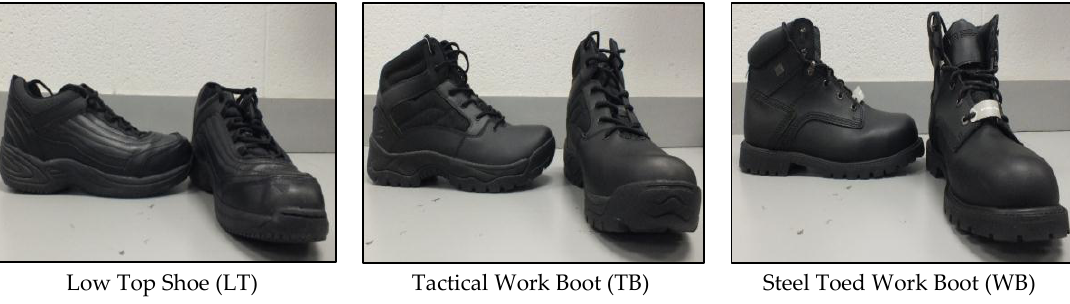
Figure 1. Occupational footwear: Low-top shoe (LT); tactical work boot (TB); and steel-toed work boot (WB).